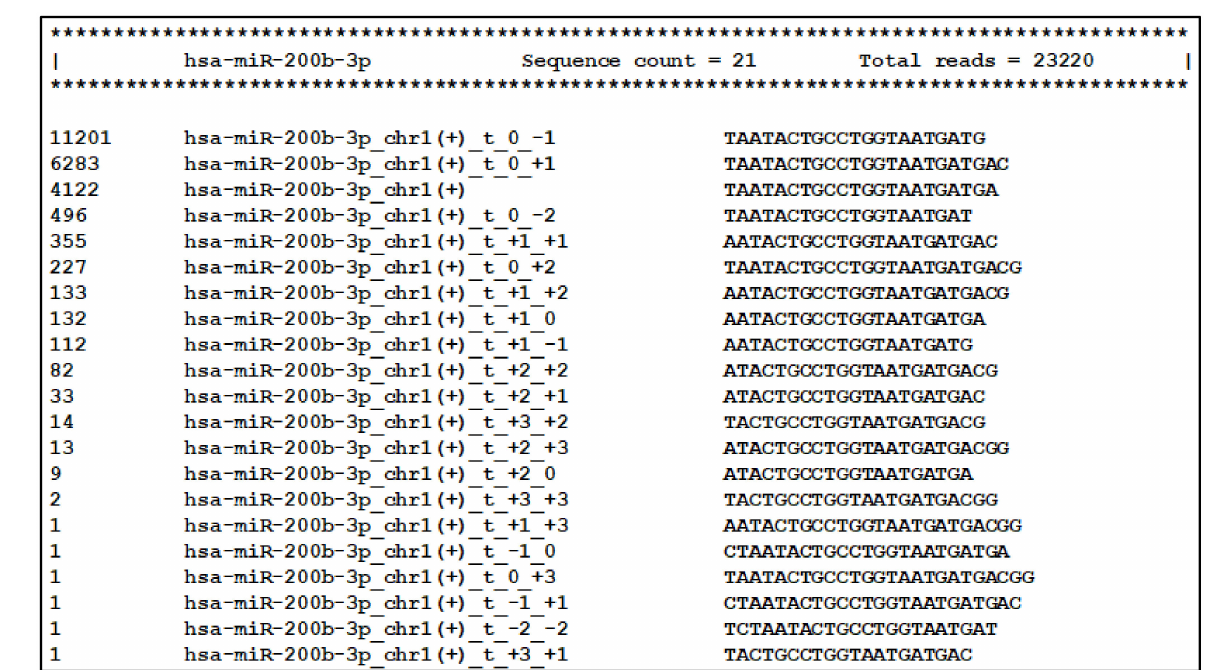
Figure 6. Visualization of the database comprising all reads produced by miR arms. Templated isomiR sequences of miR-200b-3p discovered in the milk sample are presented as an example.